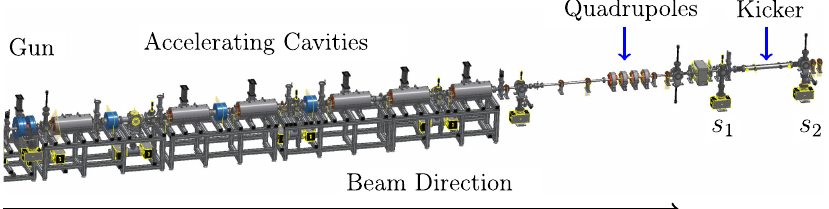
FIG. 5. Side view of the high charge linac at the AWA. All hardware in this drawing is currently installed. Note locations s 1 and s 2 , before and after the kicker.